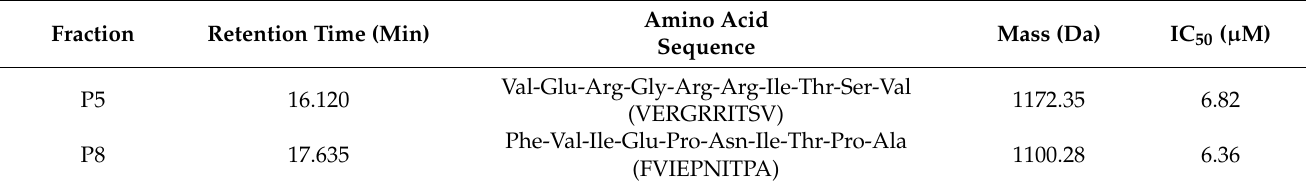
Table 1. Amino acid sequences, molecular weights, and IC 50 values on angiotensin converting enzyme (ACE) of walnut glutelin-1 hydrolysate ACE inhibitory